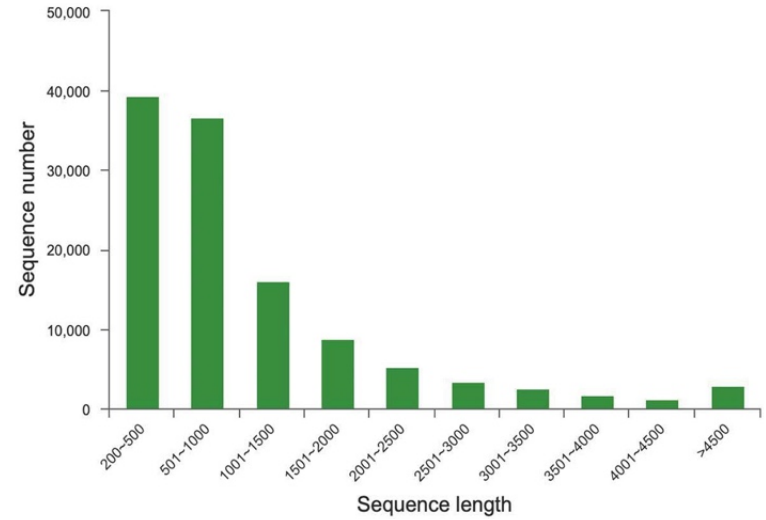
Figure 2. Sequence length distribution.